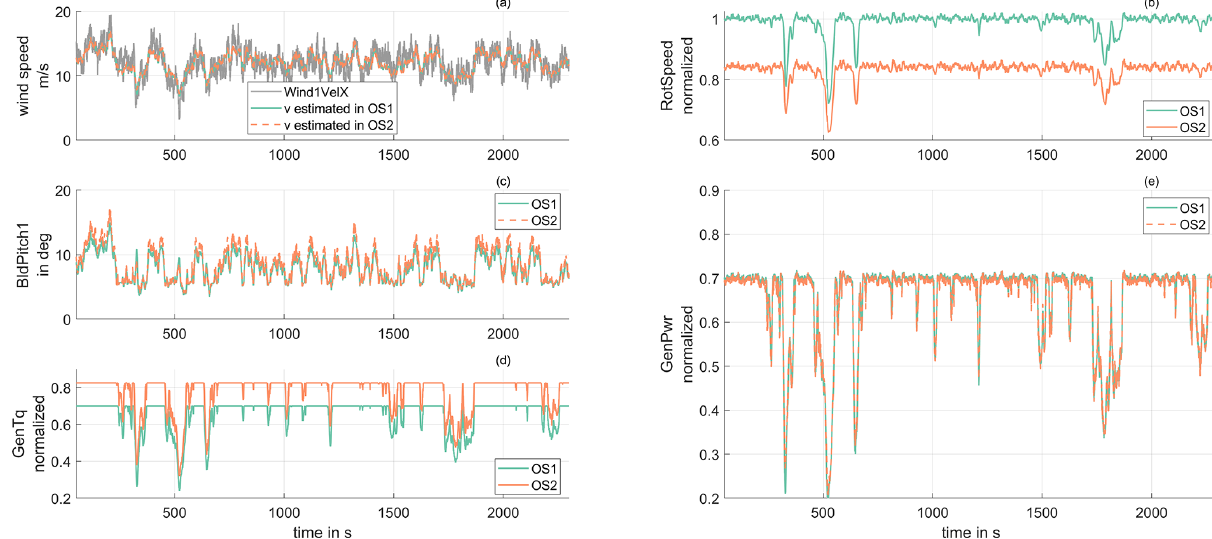
Figure 3. (a) Excitation wind speed and wind estimate of the disturbance observer, (b) wind turbine rotational speed, (c) blade pitch angle, (d) generator torque, and (e) turbine power output for OS1 and OS2 at 70% power